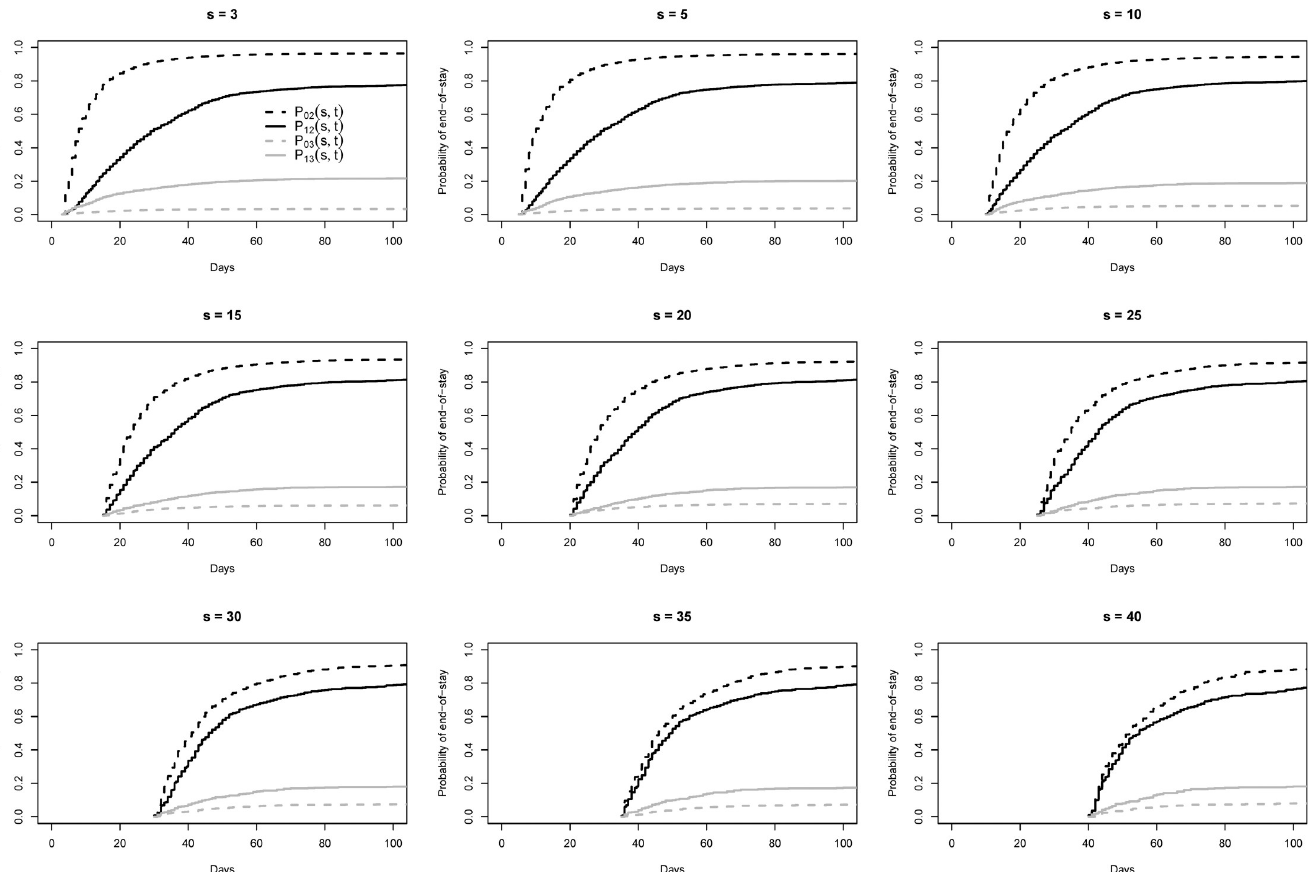
Fig 4. Results of the Aalen-Johansen estimator for patients discharged alive [P02(s, t) (black dashed lines) and P12(s, t) (black solid lines)] and for death [P03(s, t) (dark grey dashed lines) and P13(s, t) (dark grey solid lines)] for different landmark times s in surveillance period 1.